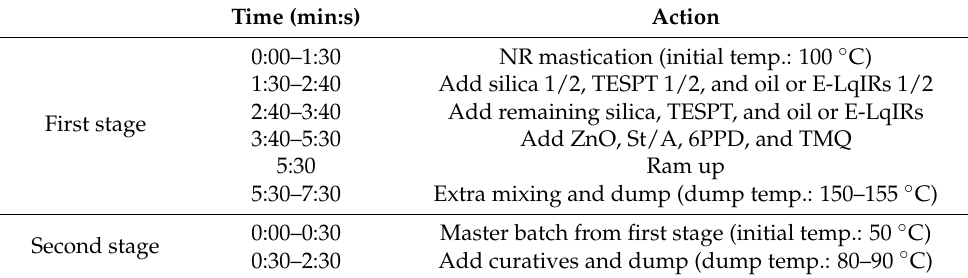
Table 2. Mixing procedure used to prepare the compounds and